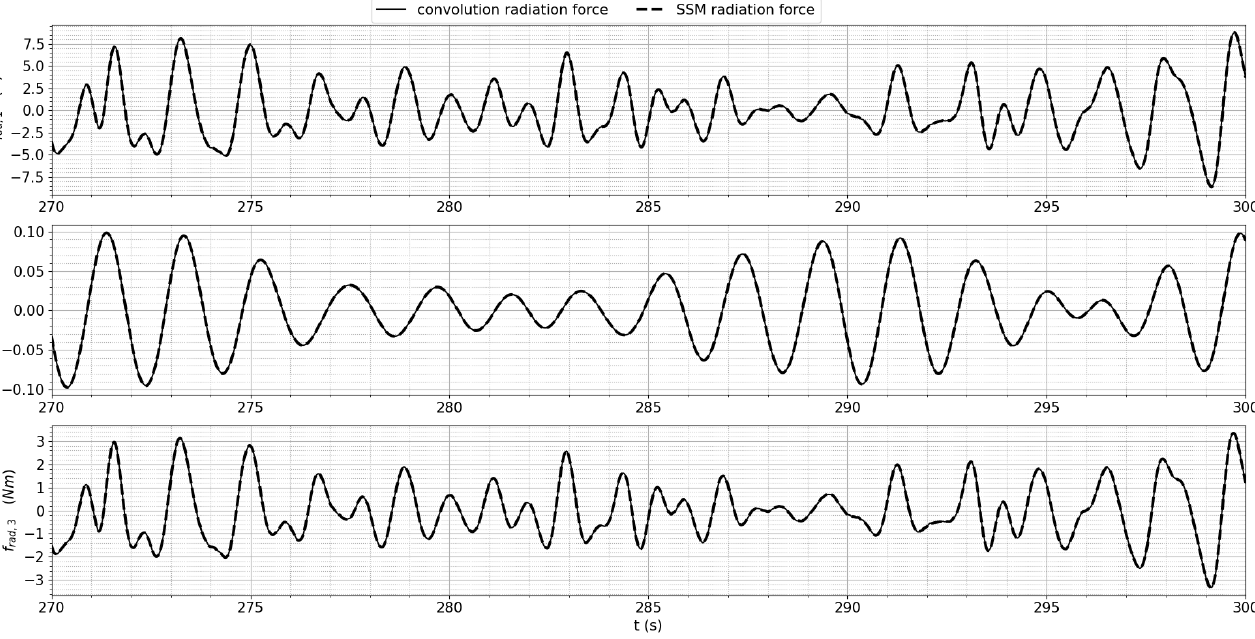
Figure 15. Comparison between convolution and